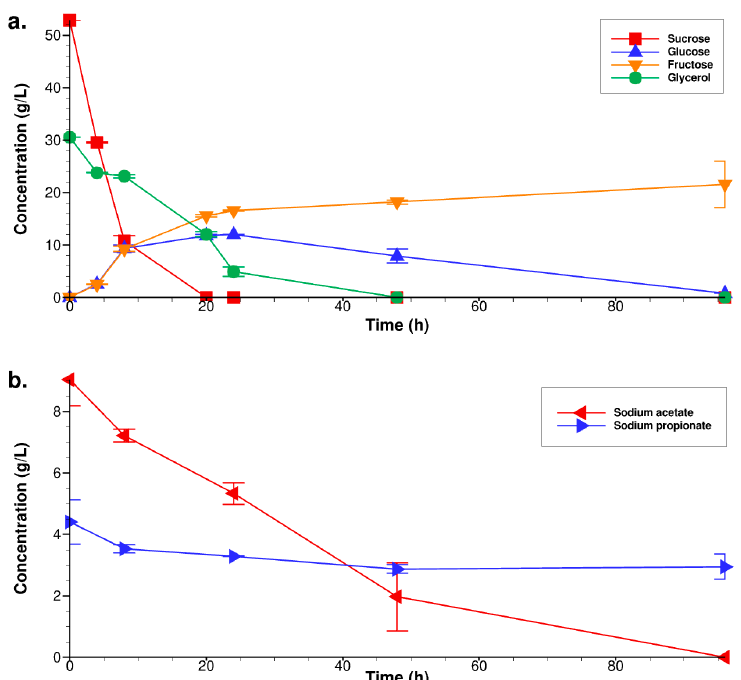
Figure 4. Growth kinetics and substrates consumption during the fermentations conducted in a 5 L bioreactor under the optimal conditions of (sucrose) = 52.4 g/L, (glycerol) = 26.9 g/L, (sodium acetate) = 10.4 g/L, (sodium propionate) = 5 g/L, and (yeast extract) = 4 g/L. ( a ) Consumption kinetics of sucrose, glucose, fructose, and glycerol. ( b ) Consumption kinetics of sodium acetate and sodium propionate.